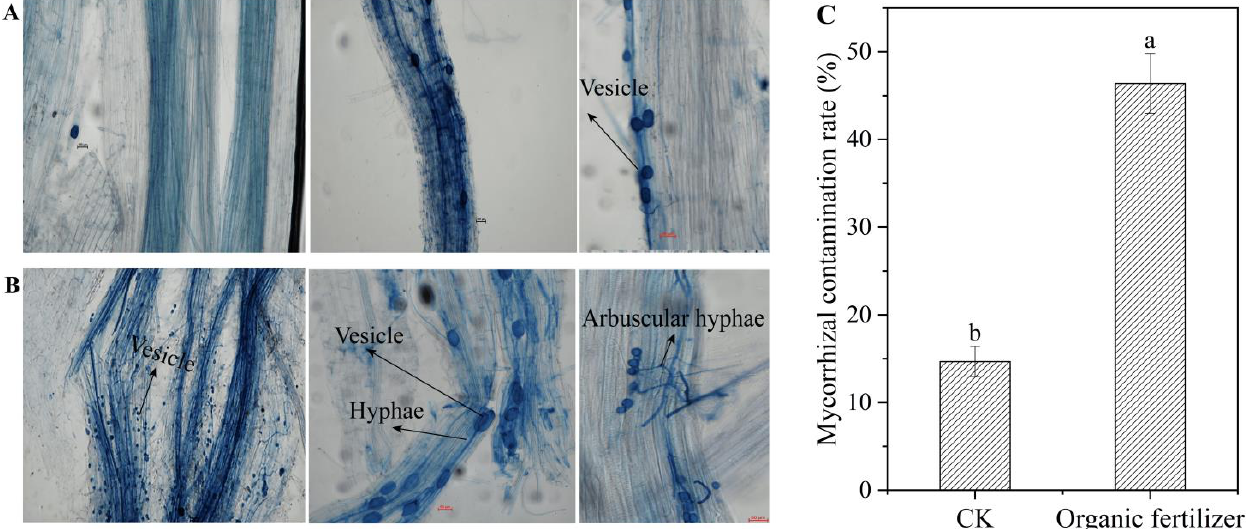
Figure 6. AMF infection in forage grass roots: AMF infection in control ( A ) and organic fertilizer ( B ) treatments; ( C ) AMF infection rates. Lowercase letters indicate statistically significant differences ( p < 0.05).